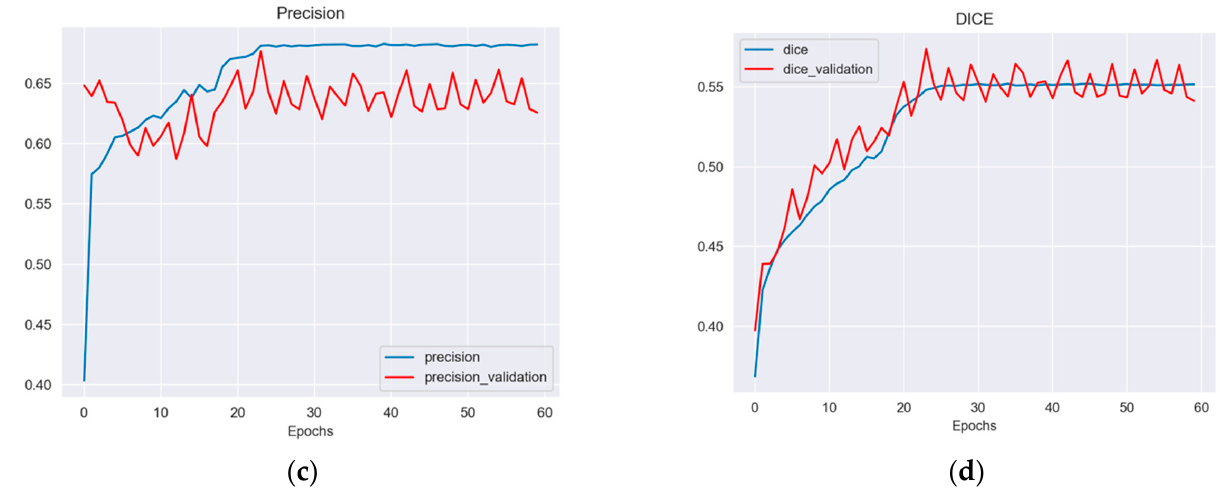
Figure 5. The plotting graphs show several metrics (( a ) Loss, ( b ) accuracy, ( c ) precision, and ( d ) DICE) concerning the different number of epochs during the training and validation of the Unet architecture.